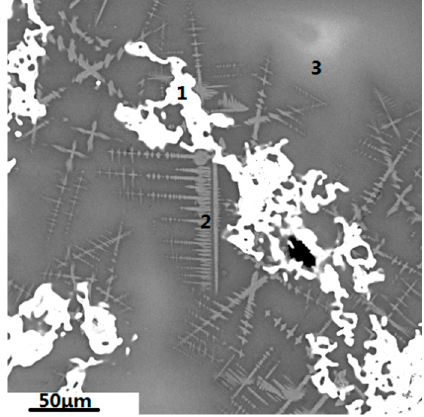
Figure 12. SEM identification for semi-crust slag sampled from experiment and 1 represents steel phase, 2 represents CaO·TiO 2 , and 3 represents slag phase.